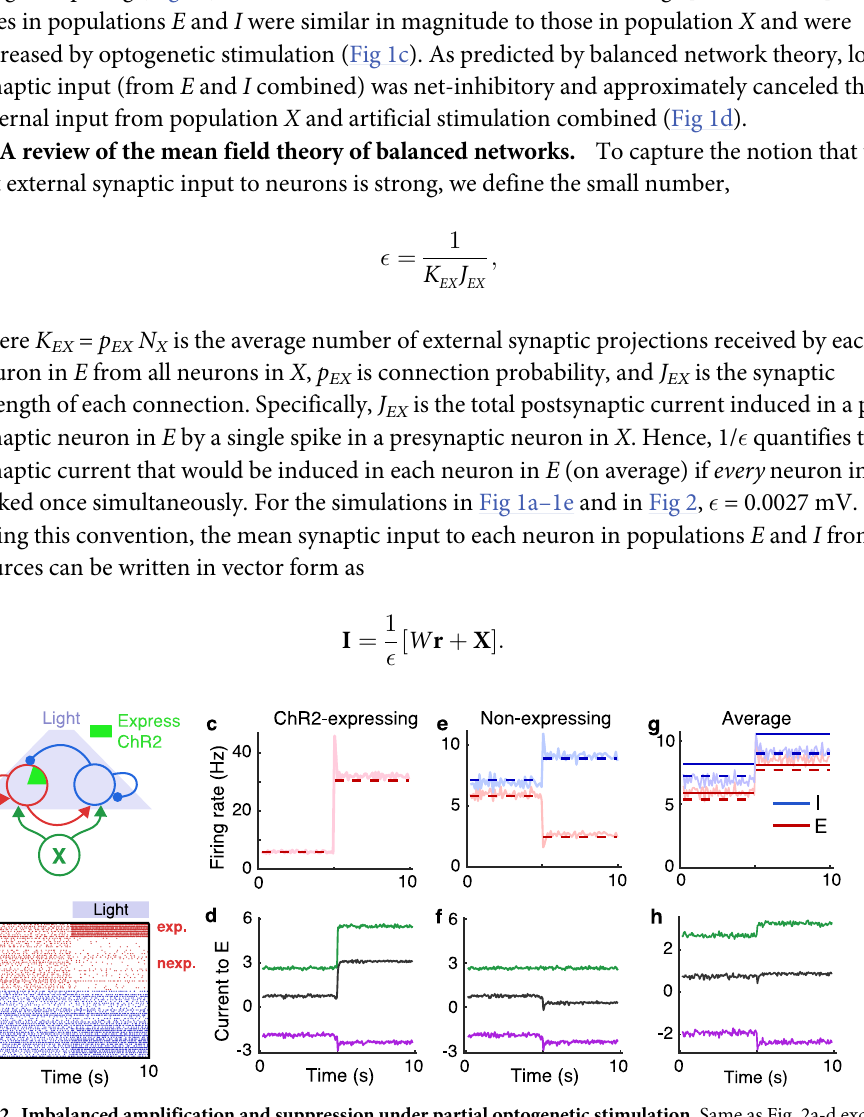
Fig 2. Imbalanced amplification and suppression under partial optogenetic stimulation. Same as Fig. 2a-d except the inward current was only provided to 20% of the excitatory neurons, modeling ChR2-expressing pyramidal cells. a) Schematic. A population of recurrently connected excitatory (red) and inhibitory (blue) spiking neuron models receive synaptic input from an external population ( X ; green) of Poisson-spiking neurons. Optogenetic stimulation of excitatory neurons was modeled by an extra inward current to 20% of the excitatory population at 5s. b) Spike rasters from 10 randomly selected ChR2-expressing and 40 non-expressing excitatory (red) neurons and 50 inhibitory (blue) neurons from the recurrent network. c) Average firing rate of ChR2-expressing excitatory neurons from simulations (light solid) and from the corrected approximation (Eq (4); dashed). d) Mean synaptic currents to 200 randomly selected ChR2-expressing excitatory neurons from external inputs ( X ; green), from the local population ( E + I ; purple) and the total synaptic current (black). e) Same as c, but for non-expressing excitatory neurons (red) and inhibitory neurons (blue). f) Same as d, but for non-expressing excitatory postsynaptic neurons. g) Same as c and d, but averaged over all excitatory neurons (expressing and non-expressing). Currents are measured in units of the neurons’ rheobase (rheobase/ C = 10.5 V/s). Firing rates predicted by Eq (3) are not shown in c and e because Eq (3) is not applicable to m those